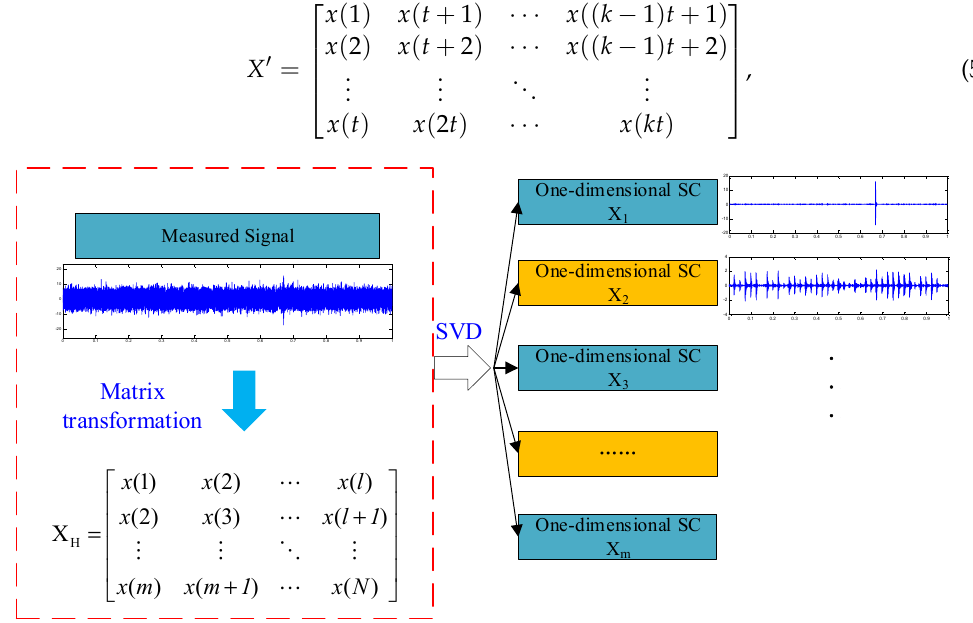
Figure 5. Schematic diagram of the singular value decomposition process.